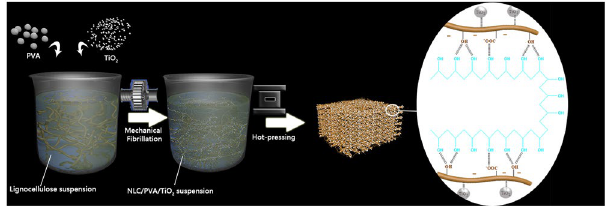
Figure 1. Schematic illustration of fabrication of Nacre-like NLC/PVA/TiO 2 composite